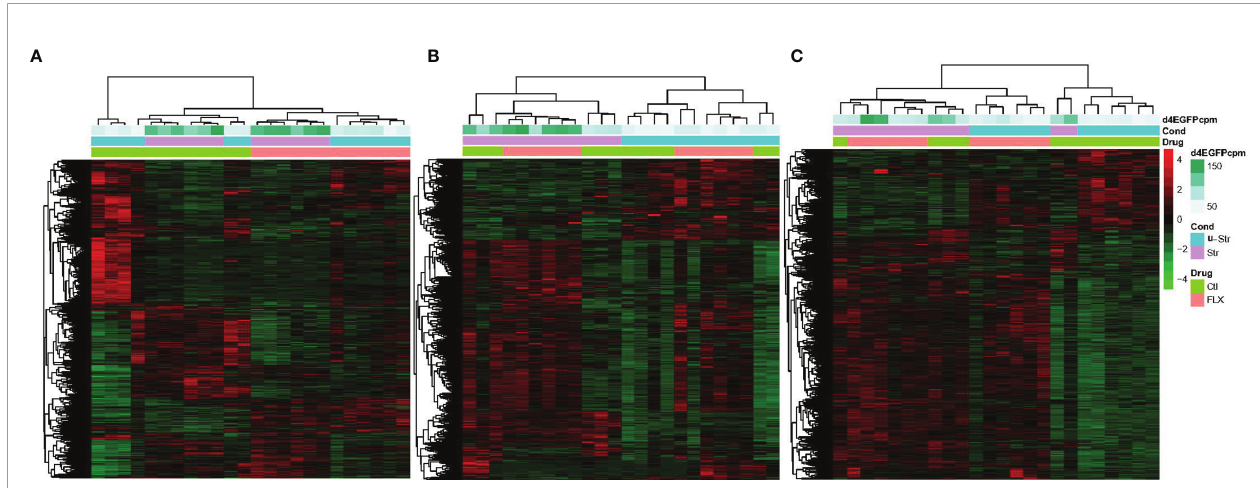
FIGURE 2 | The effect of developmental fl uoxetine exposure on transcriptome patterns in larval and adult male zebra fi sh central nervous system in the unstressed and stressed conditions. Hierarchical clustering (Spearman correlation) is shown for all 24 samples (stressed, unstressed, fl uoxetine-exposed, and control ethanol- exposed) in a single pooled tissue sample (i.e., larval head, hypothalamus, and telencephalon) and their relation to FLX and stress. (A) FLX-exposed larvae compared to the control larvae. (B) telencephalon from adults exposed to FLX in the early life developmental stage compared to control adults exposed to vehicle compound (ethanol) in the early life developmental stage. (C) hypothalamus from adults exposed to FLX in the early life developmental stage compared to control adults exposed to vehicle compound (ethanol) in the early life developmental stage. The Y-axis consists of all genes with signi fi cant fold change (FDR ≤ 0.05 and FC ≥ 1.2) in the treatment groups relative to the control groups. The count per million (CPM) of the reads associated with the green fl uorescent protein (d4eGFP) transgene in the SR4G zebra fi sh line is shown. The different shades of green show different CPM. Red: up-regulation, green: down-regulation. Blue: unstressed condition, Lavender: stressed condition, Light Green: control (ethanol), Pink: